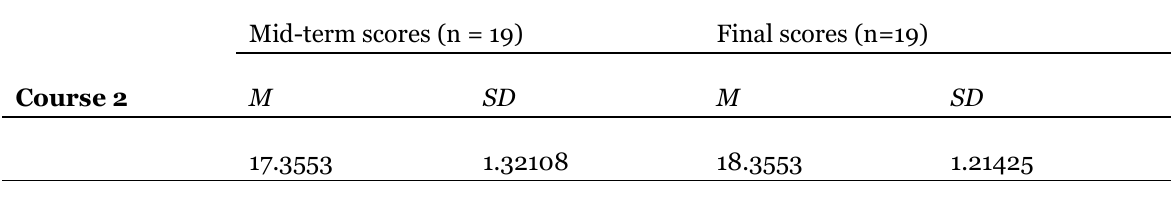
Test of normality Shapiro-Wilk = 0.958 p =